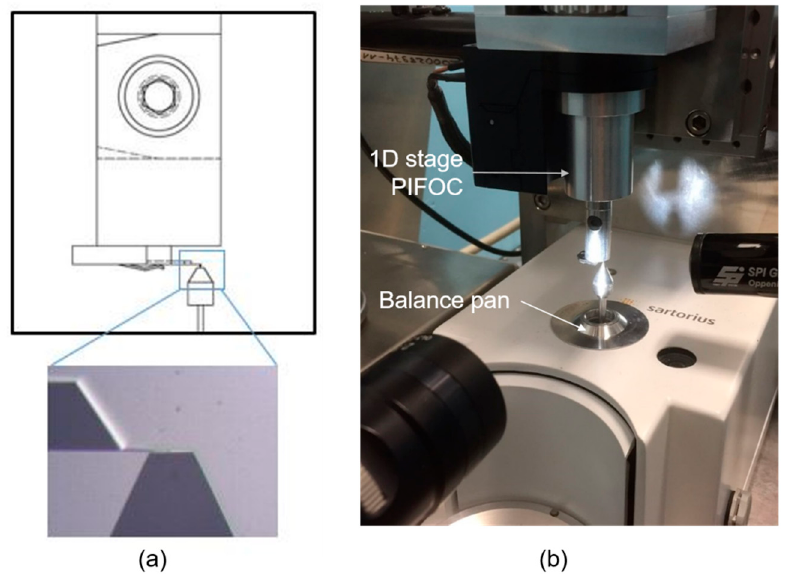
Figure 1. Experimental setup for cantilever stiffness calibration: ( a ) schematics and ( b ) photograph. During stiffness calibration measurement, the cantilever was equidistantly and mentally moved down in defined steps (~0.1 µ m) until it touched the ruby sphere incrementally moved down in defined steps (~0.1 µm) until it touched the ruby sphere and some micrometers further in order to measure the probing curve. Force deflection curves were then measured up to a maximum force of 10.2 µN. The position of the cantilever and the mass of the compensation balance were then simultaneously recorded.